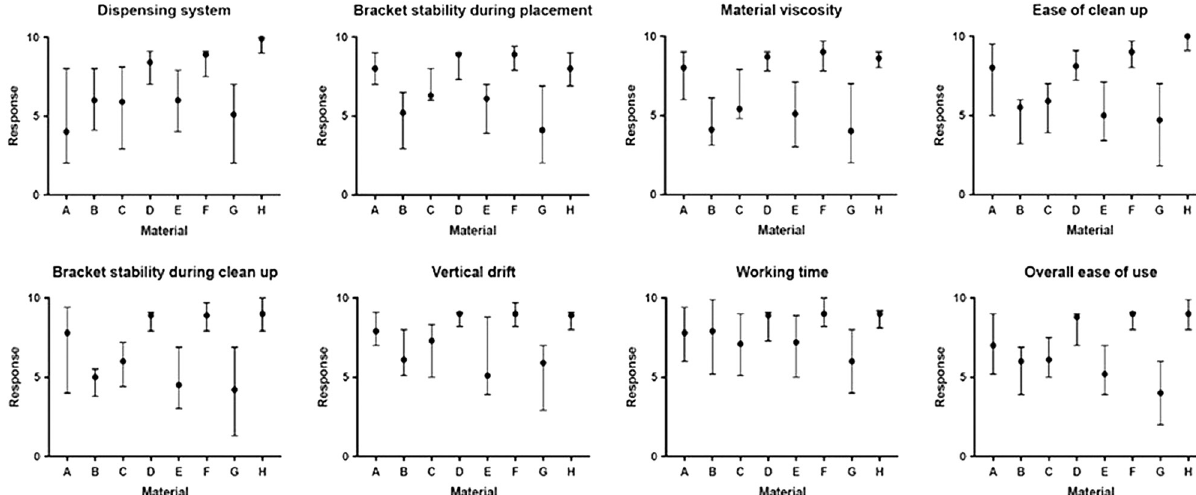
Figure 2. Line graphs depicting median, 25th and 75th percentile Visual Analogue Scale (VAS) responses. Material key—A: Fuji ® II LC, B: Ortholy Glass Bond, C: Fuji Ortho™ LC (capsule), D: Light Bond™ thin paste, E: Fuji Ortho™ LC (paste pak), F: Transbond™ XT, G: F2A-10-2 (trial material), H: APC™ Flash-Free Adhesive Coated Appliance System.